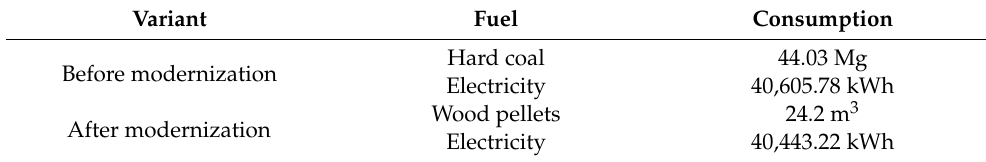
Table 7. Annual consumption of energy carriers.